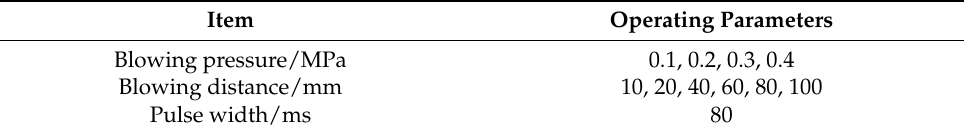
Table 2. Operation parameters of the